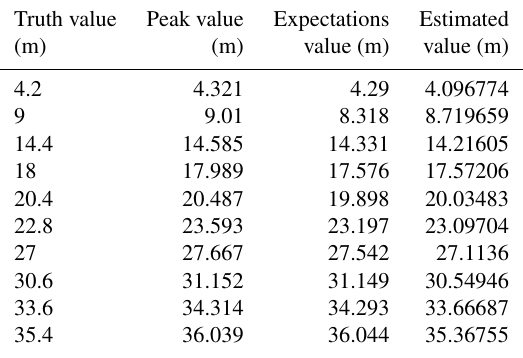
Table 3. Results of true value estimation for 10 sets of test data. Truth value Peak value Expectations